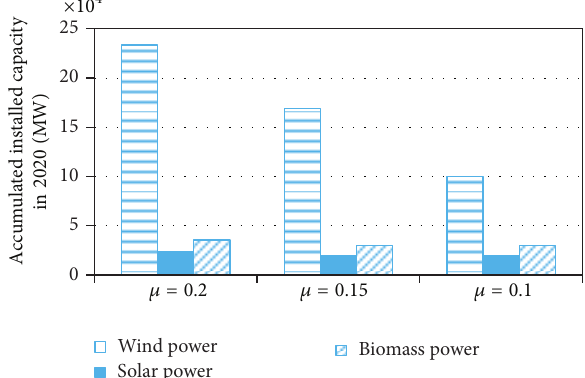
Figure 4: The unit investment costs of power from three renewable sources.